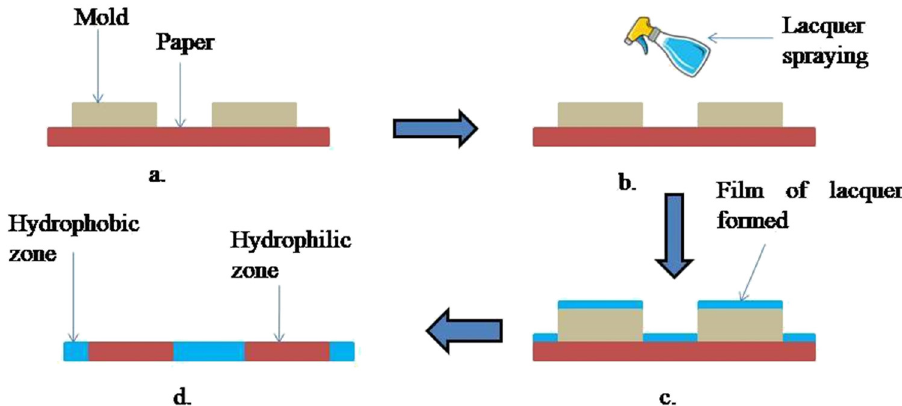
Figure 4: Lacquer spraying method for fabrication of PADs: ( a ) mould a ffi xed on paper, ( b ) spraying of hydrophobic lacquer, ( c ) fi lm of lacquer is formed over paper and mould, and ( d ) fabricated PAD by lacquer